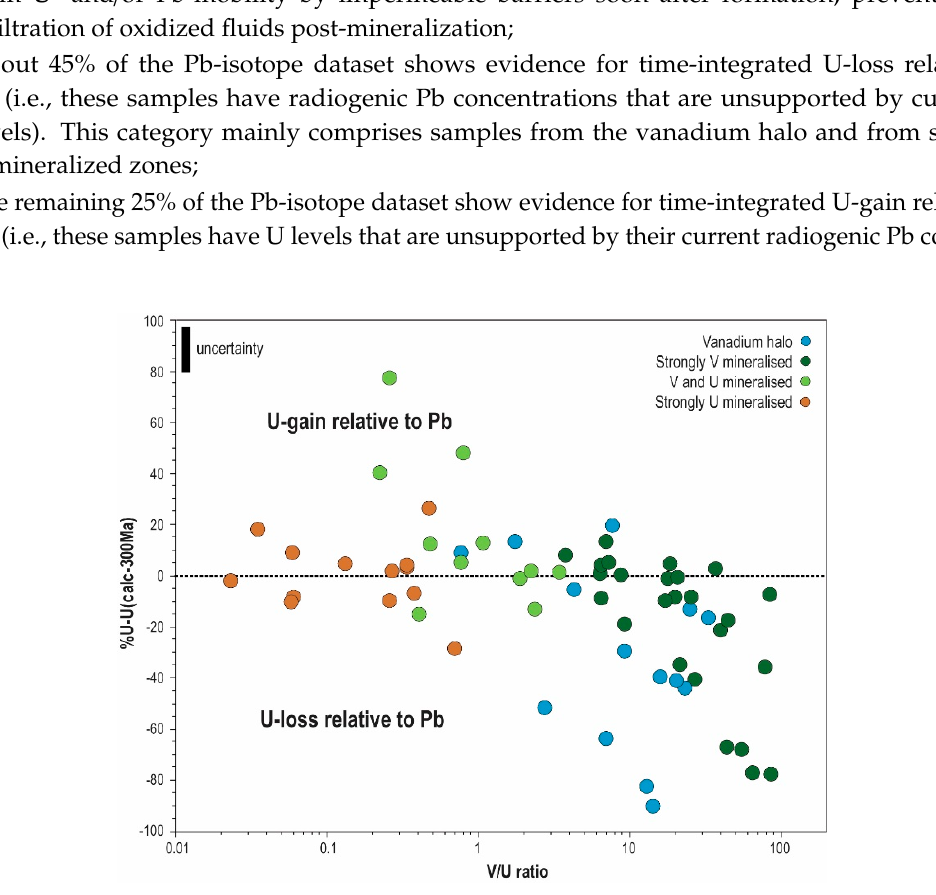
Table 3. Downhole variation of U, V, Pb and calculated U based on radiogenic Pb.